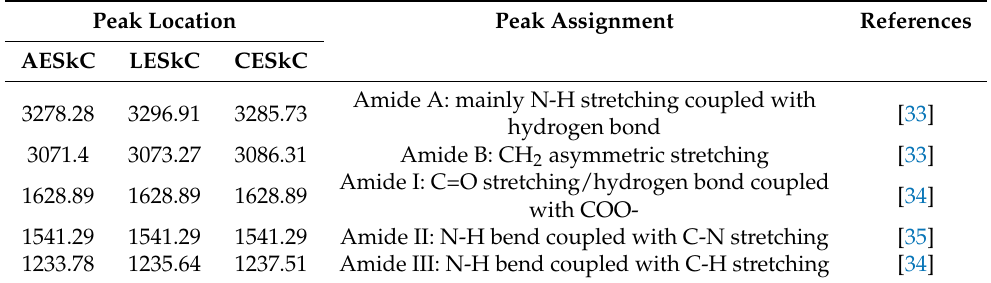
Figure 2. Fourier transform infrared spectroscopy peak locations and the assignment for collagens from the skin of lizardfish. AESkC: acetic acid-extracted collagen; LESkC: lactic acid-extracted collagen; CESkC: citric acid-extracted collagen.